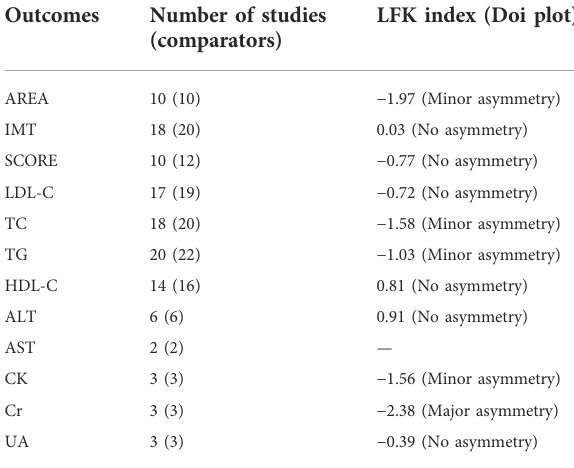
TABLE 2 Publication bias of the